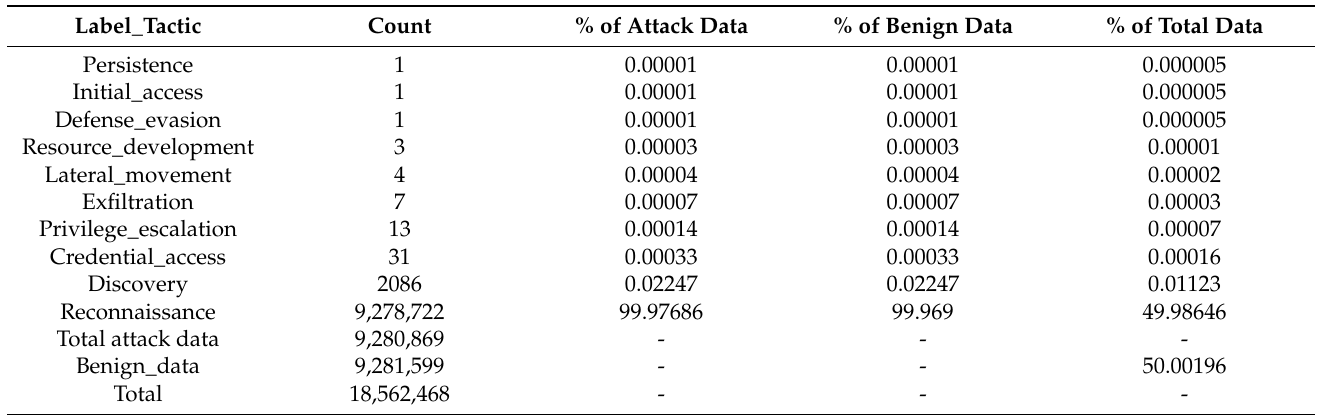
Table 2. UWF-ZeekData22: distribution of MITRE ATT&CK tactics